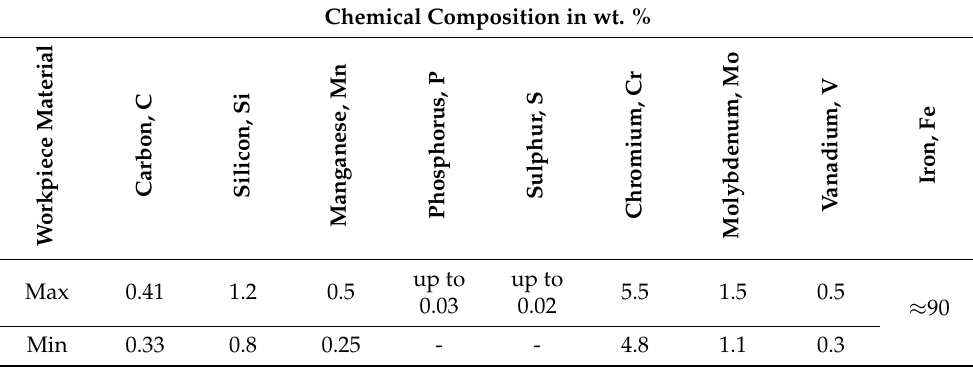
Table 3. Chemical composition of X37CrMoV5-1 steel. Chemical Composition in wt.